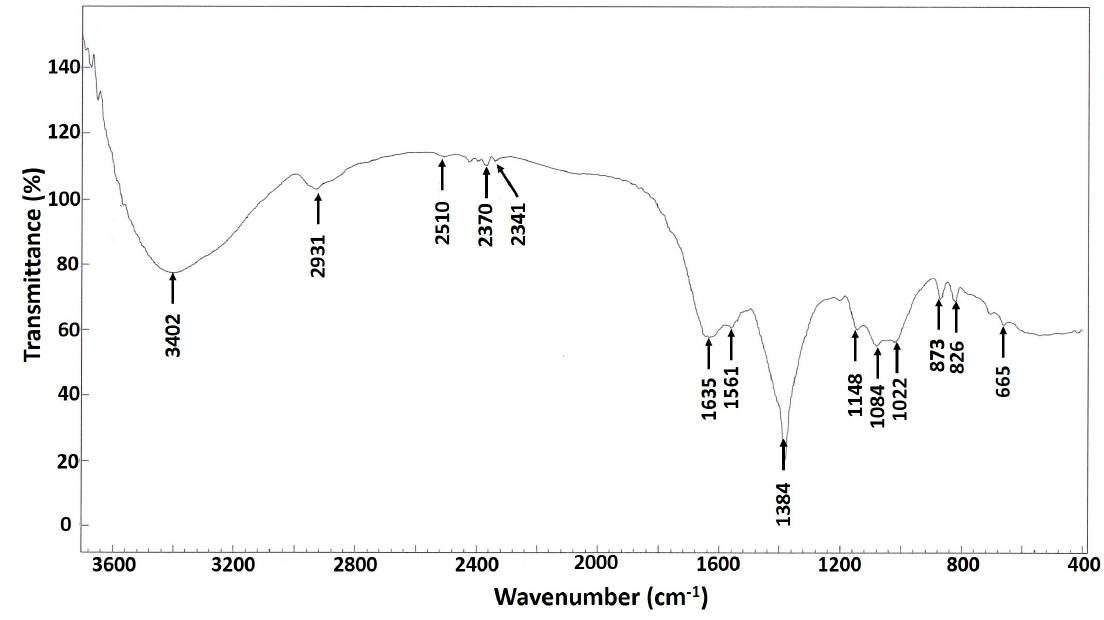
Figure 3. FT-IR spectrum of the Ag-NPs derived from endophytic S. antimycoticus L-1 .